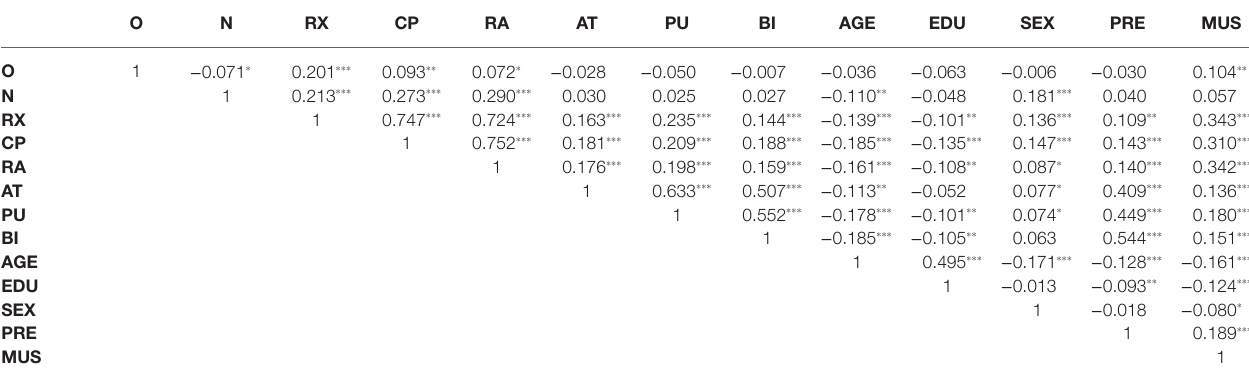
TABLE 4 | Correlation